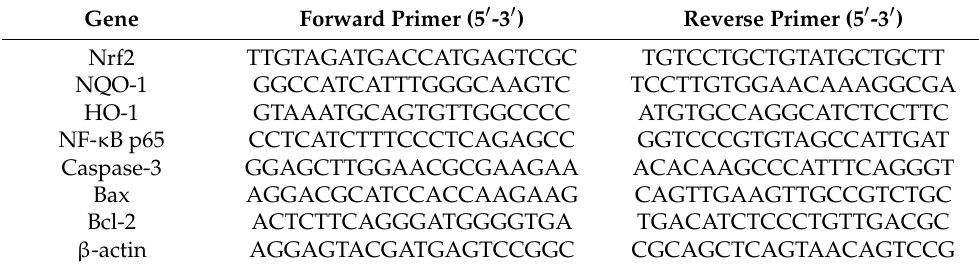
Table 1. Primers used for